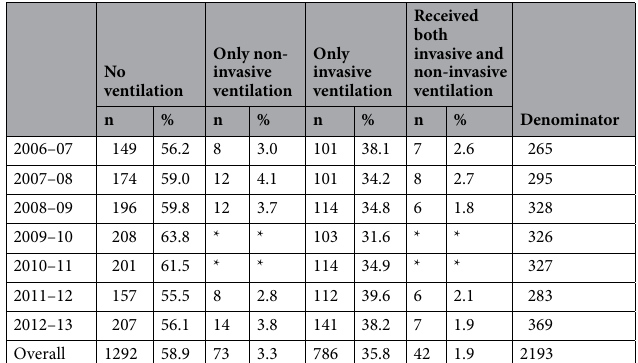
Table 2. Number and percentages of paediatric admissions in England in the financial years in PICANet by ventilation provided. *One of those counts were less than 5, hence four are starred to prevent disclosure.